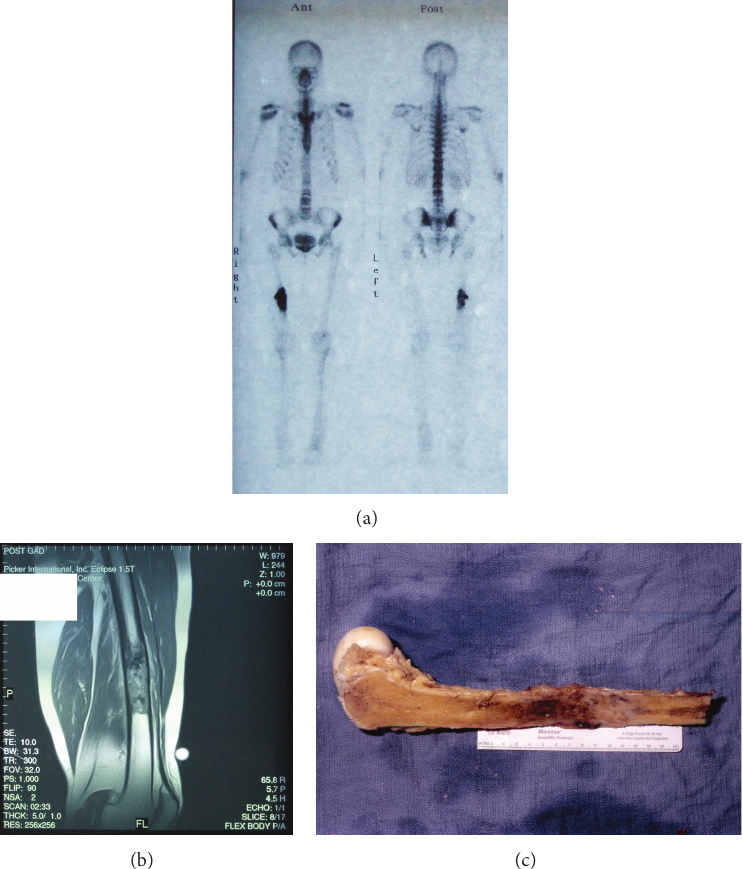
Figure 1: Osteosarcoma. (a) Whole body scan shows abnormally intense uptake of the radionuclide (Tc) within the middiaphysis of the right femur. No increased radionuclide uptake is seen anywhere else in the bony skeleton. (b) MRI scan displays an extensively abnormal signal in the diaphysis of the right femur. It is surrounded by soft tissue involvement. (c) Bone lesion displayed